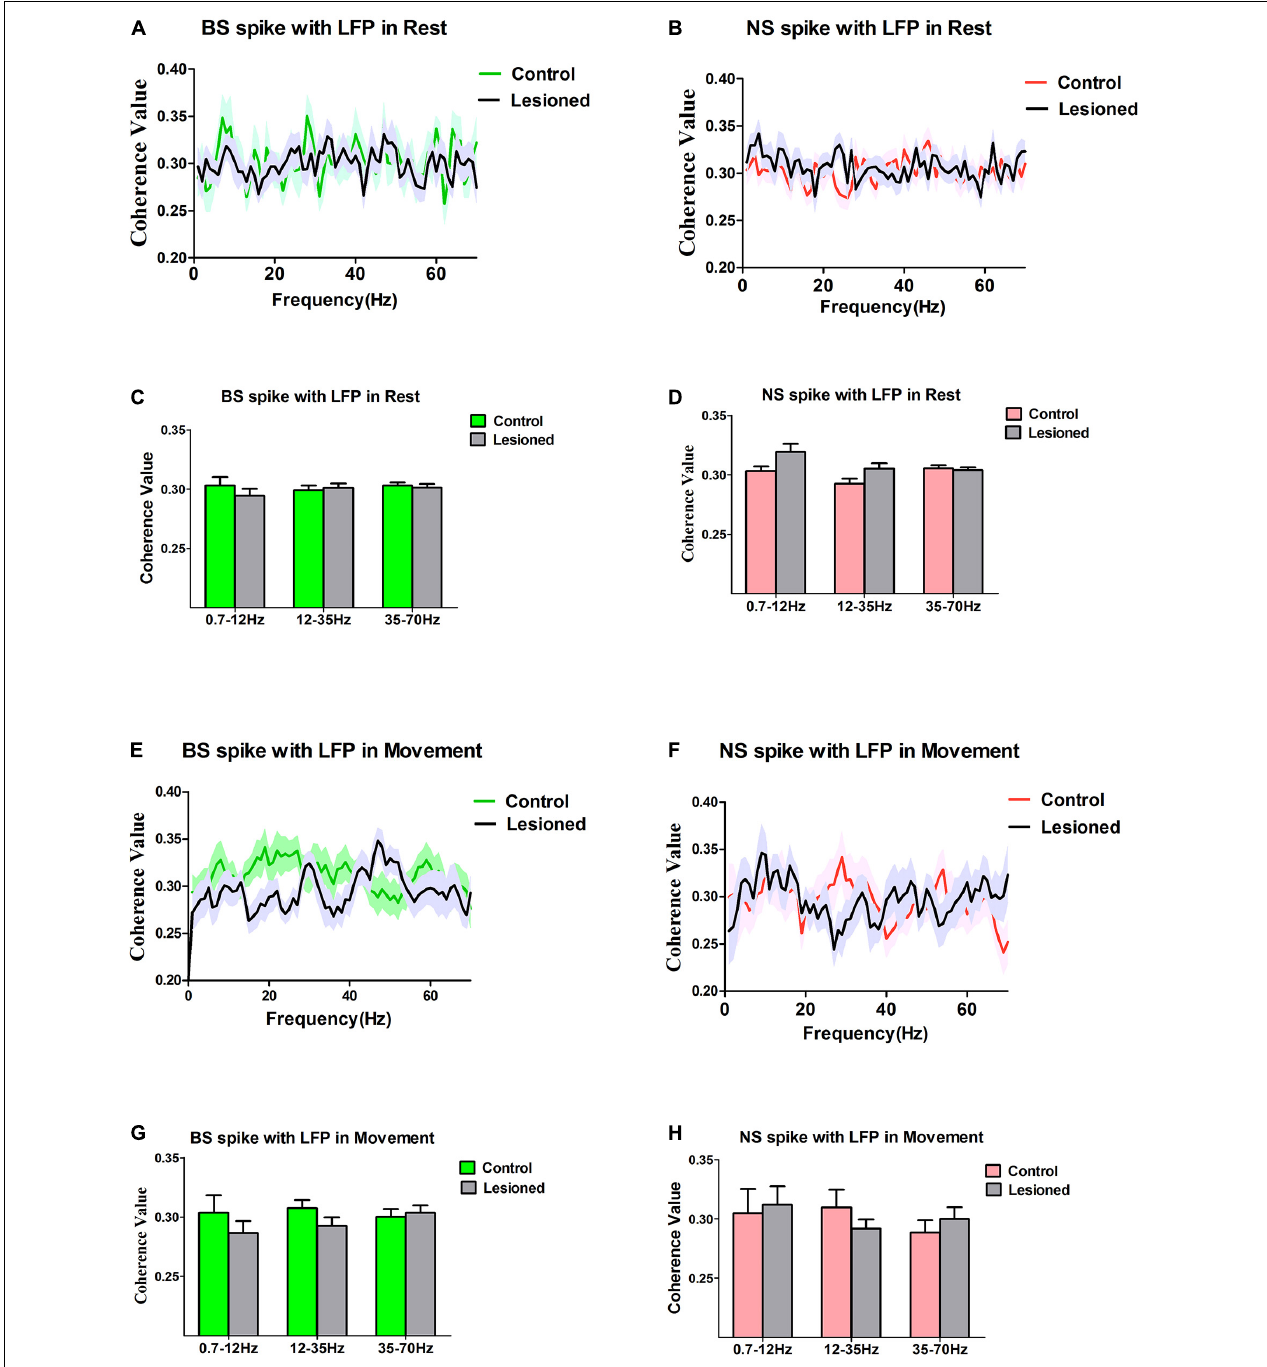
FIGURE 9 | Characteristics of the Coherent values between the BS or NS neuron M1 spike activities with respect to LFP in dopamine-intact rats and 6-OHDA-treated rats. During the resting epoch, coherent values between BS ( n = 31 neurons in control, 27 neurons in 6-OHDA-treated) and LFP activity at the 0.7–12 Hz, 12–35 Hz, and 35–75 Hz do not change significantly following dopamine cell lesion (A,C) , nor does it change in the NS ( n = 26 neurons in control rats, 24 in 6-OHDA-treated rats) (B,D) . During the movement epoch, mean coherent values between BS spikes and LFP activity at the 0.7–12, 12–35, and 35–75 Hz exhibit no alteration in 6-OHDA-treated rats ( n = 22 neurons) compared to the intact rats ( n = 27 neurons) (E,G) , and there was no significant difference in the coherence between NS ( n = 21 neurons in control, 23 in 6-OHDA-treated) spike-LFP pairs (F,H) .